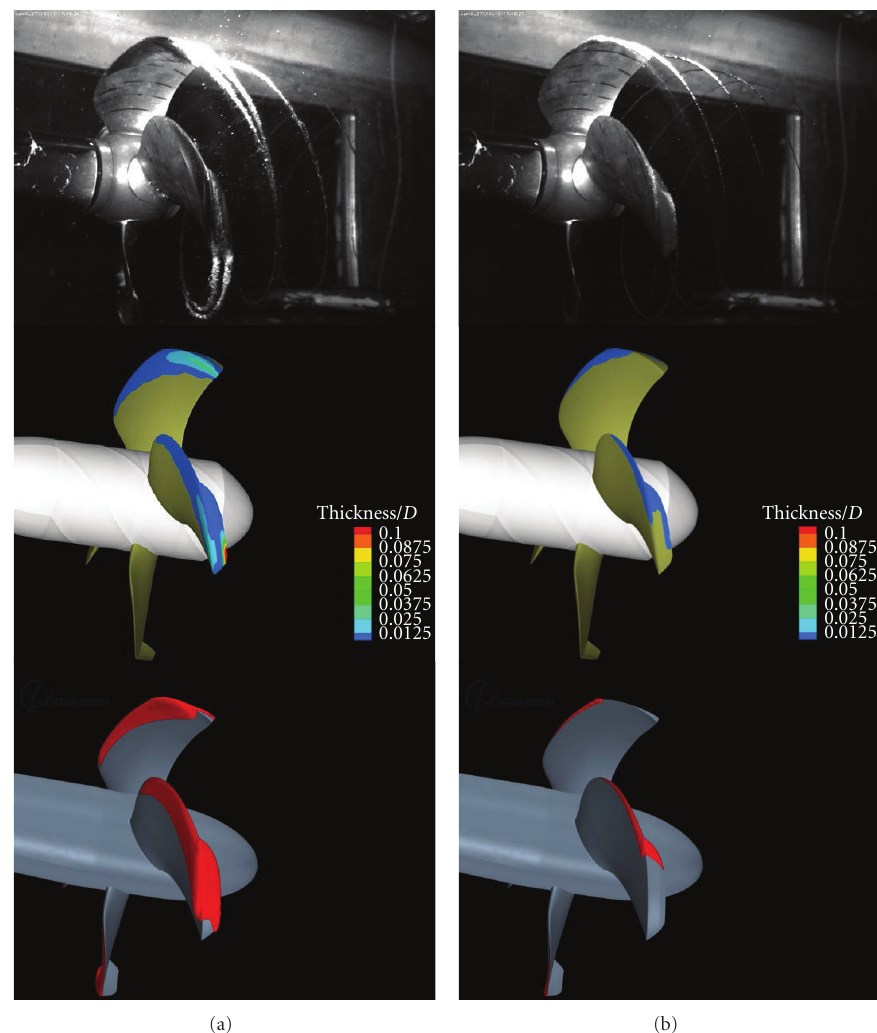
Figure 22: Cavity extension for open water KT equal to 0.213, at cavitation index of 1.5 (a) and 3.3 (b). Comparison with panel and RANSE numerical